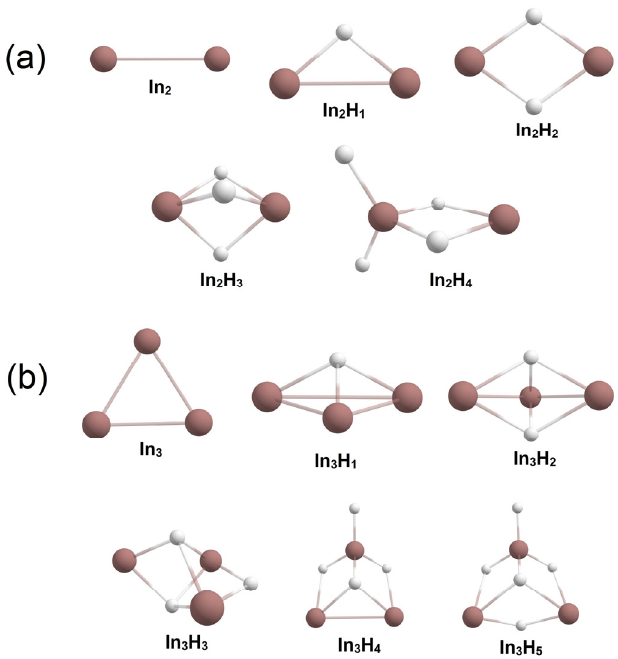
Figure 1. Global minimum structures of ( a ) In 2 H x (x = 0–4), ( b ) In 3 H y (y = 0–5). According to the AdNDP analysis, completely unsaturated structures In 2 and In 3 have similar bonding patterns. In the case of the In 2 molecule in the first triplet state, we found two 1c-2e lone pairs, one 2c-1e σ -bond with ON = 0.99e, and one 2c-1e π -bond with ON = 0.99e, where “ON” stands for occupancy number, and “e” reflects that occupancy number is related to the number of